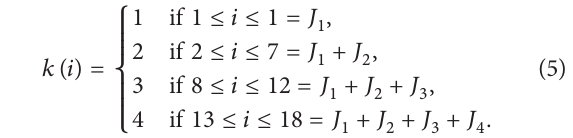
Table 3: Estimation of the autonomous model parameters, 𝛼 𝑖 , separated by clusters.